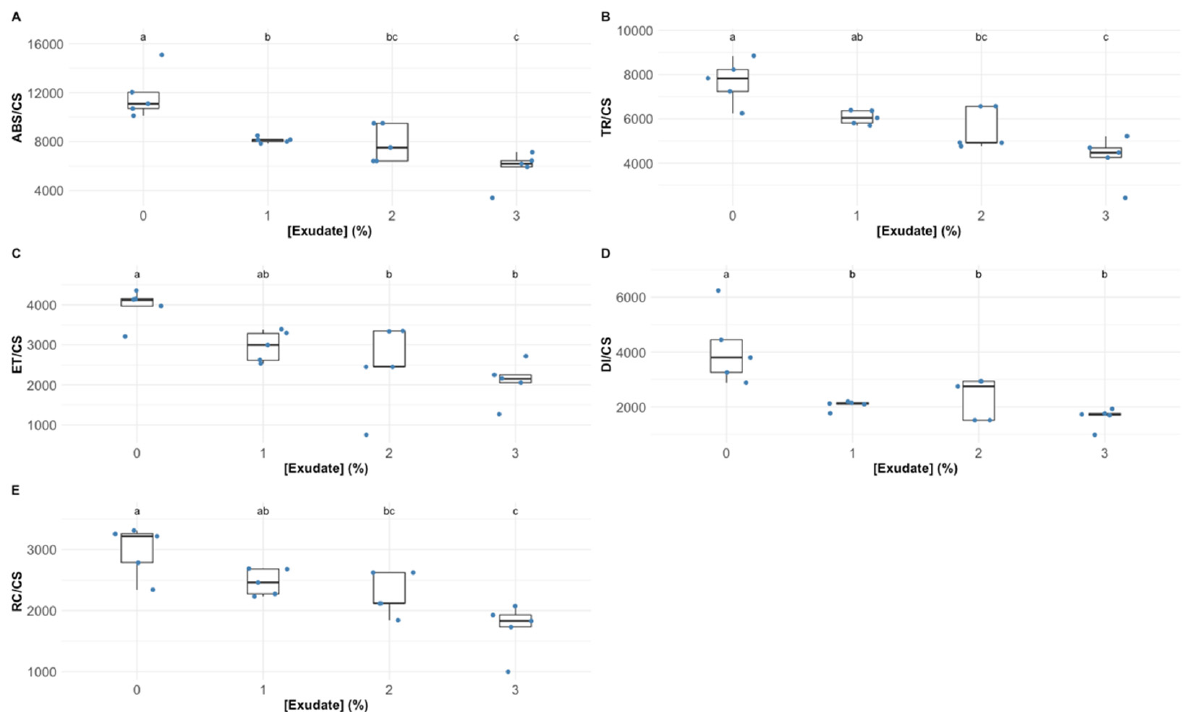
Figure 3. Thellungiella halophila phenomological energy fluxes absorbed (ABS/CS) ( A ), trapped (TR/CS) ( B ), trans- ported (ET/CS) ( C ), and dissipated (DI/CS) ( D ), and the number of available reaction centres per cross-section (RC/CS) ( E ) in leaves exposed to Asparagopsis armata exudate at the proposed target concentrations at the end of the trial period (N = 5 per treatment; letters denote significant differences between treatments at p <